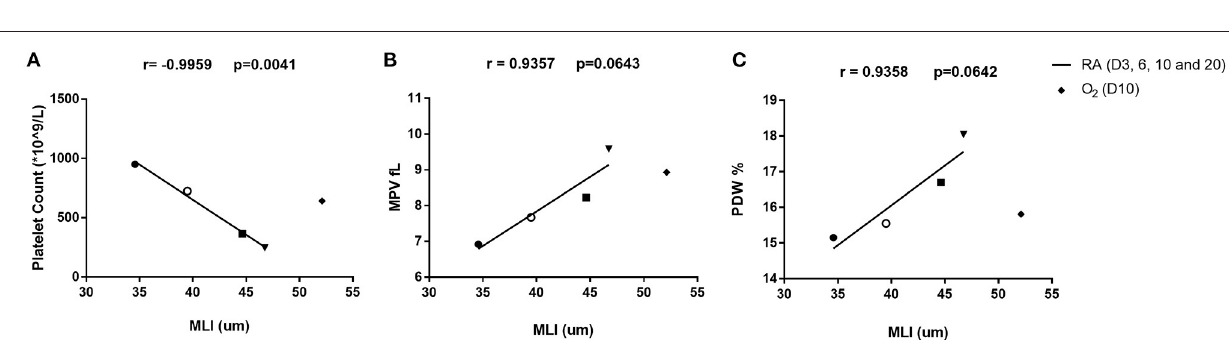
FIGURE 5 | Correlation analysis between platelet parameters and MLI in rats on day 3, 6, 10, and 20 after birth. Correlation between platelet count (PLT) and MLI (A) , mean platelet volume (MPV) and MLI (B) , platelet distribution width (PDW) and MLI (C) . The correlation was analyzed by Pearson correlation using GraphPad Prism version 8. Triangles ( H ) indicate 3-day old rats. Squares ( (cid:4) ) indicate 6-day old rats. Open circles ( ◦ ) indicate 10-day old rats and solid circles (•) indicate 20-day old rats. Diamonds ( (cid:7) ) stand for rats exposed to hyperoxia for 10 days in a row. The hyperoxia data were only plotted in the figure but not included in the correlation